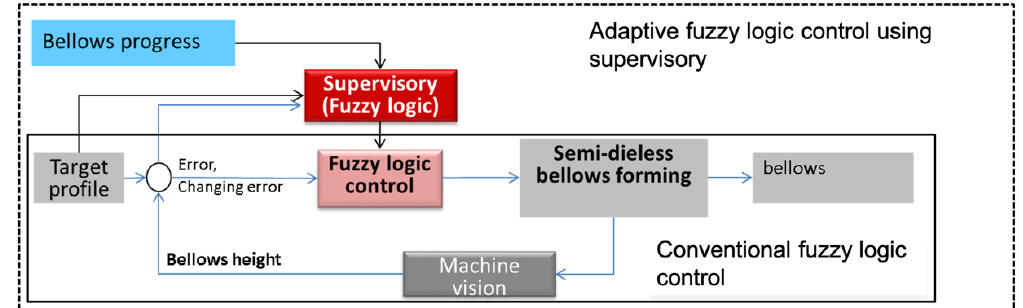
Figure 11. Flowchart of the semi-dieless bellows forming with a vision-based fuzzy control.